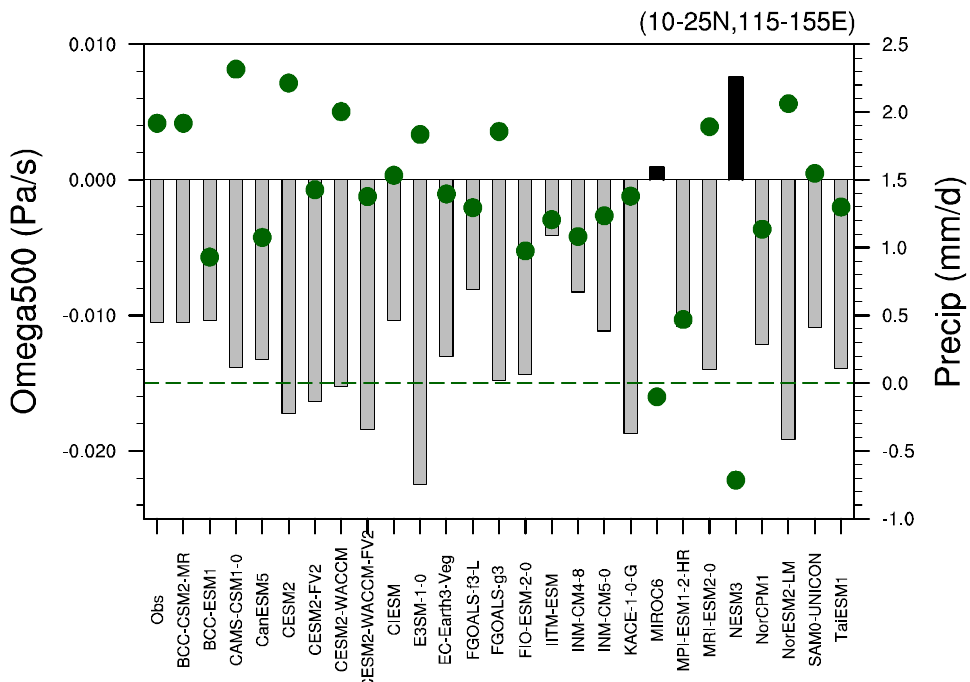
Figure 10. The same as Figure 8, but for the vertical velocity at 500-hPa (units: Pa/s).